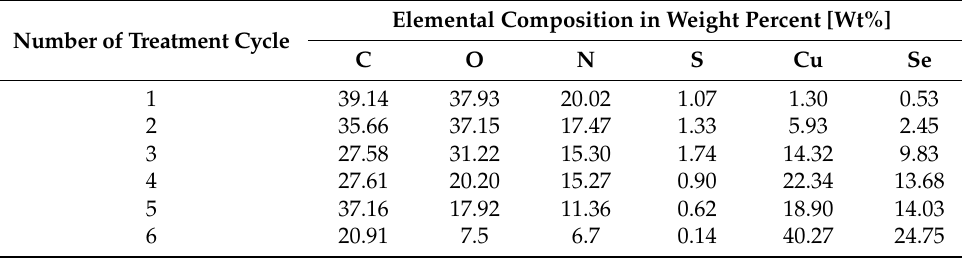
Table 4. Surface elemental composition of the investigated treated wool fibers.